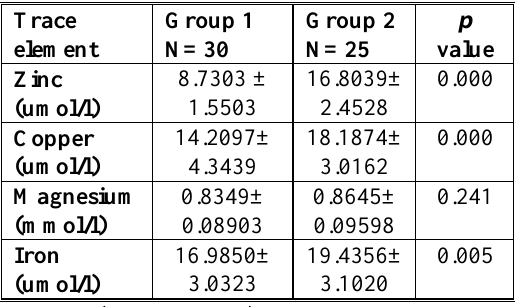
Table ( 2): Serum levels of Zinc, Copper, Magnesium and Iron in groups